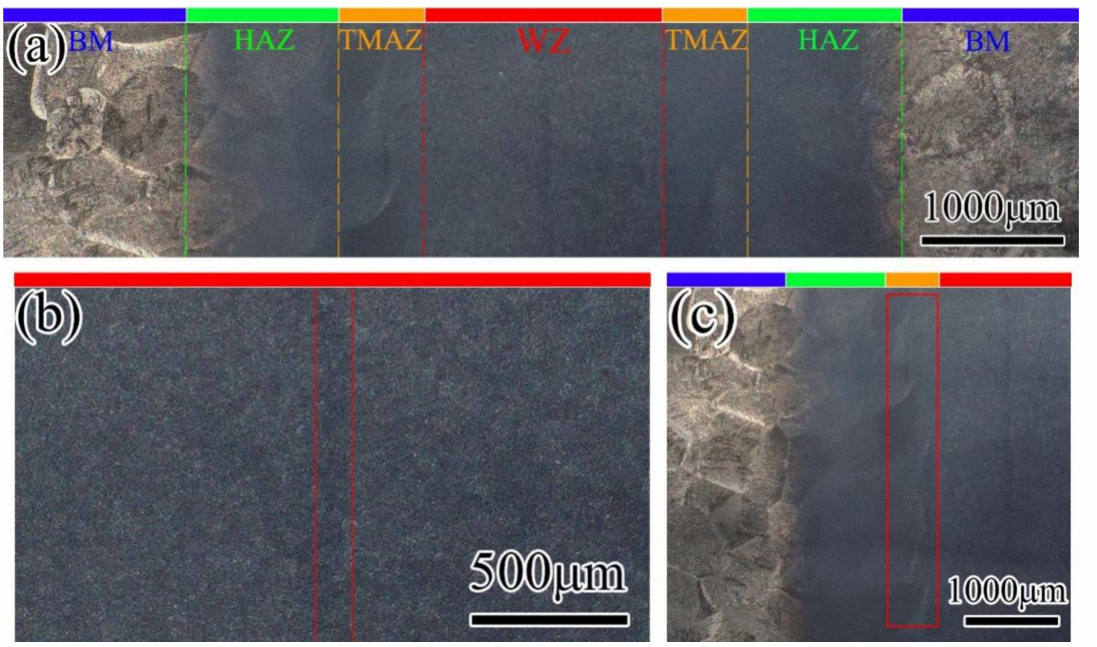
Figure 2. Optical micrographs of the IFW joint ( a ) overall IFW joint; ( b ) WZ with relatively higher microscope magnification; ( c ) part of the IFW